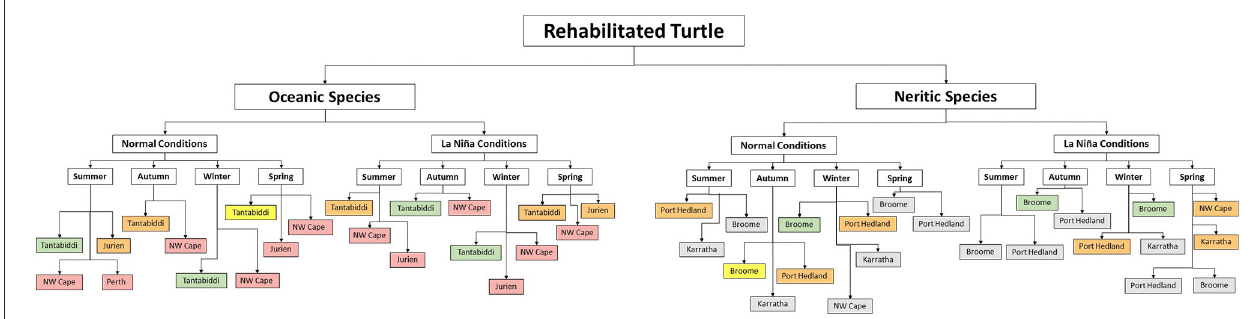
FIGURE 6 | A decision support system to inform the release of rehabilitated sea turtles, with both oceanic and neritic life histories, in Western Australia based on 2010 (normal) and 2011 (La Niña) conditions. The colors indicate the suitability of a site in relation to the percentage of successful particles; green is “Very High” (70–100%), yellow is “High” (50–70%), Orange is “Medium” (30–50%), red is “Low” ( < 30%) and gray is “indeterminate” ( <